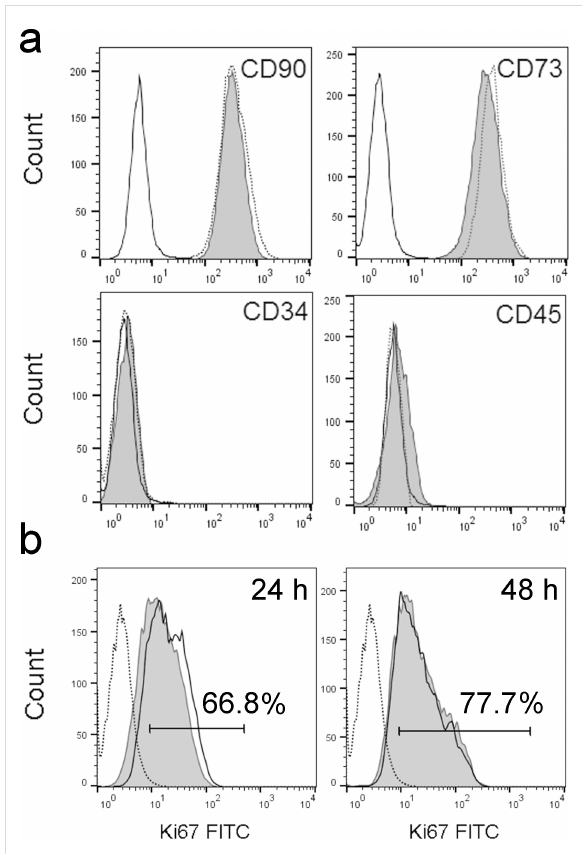
Figure 4: Representative data on the impact of QDs on immunophe- notype and proliferation of MSCs. (a) Characterization of MSC markers CD90, CD73 and hematopoietic markers CD34 and CD45 in MSCs. Open histogram: unlabelled cells, dotted-line histogram: MSCs without QDs, grey histogram: QD-labelled MSCs. (b) Ki67 expression in MSCs after 24 h and 48 h of incubation with 16 nM QDs. Open histogram: unlabelled cells, dotted-line histogram: isotype control, grey histogram: QD-labelled cells.